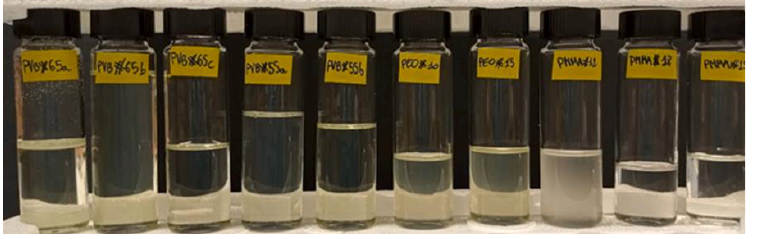
Figure 7. A representative picture of several PGEs considered in this study, from left to right are PVB#65a, PVB#65b, PVB#65c, PVB#55a, PVB#55b, PEO#10, PEO#15, PMMA#12, PMMA#18, PMMA#23 [65].